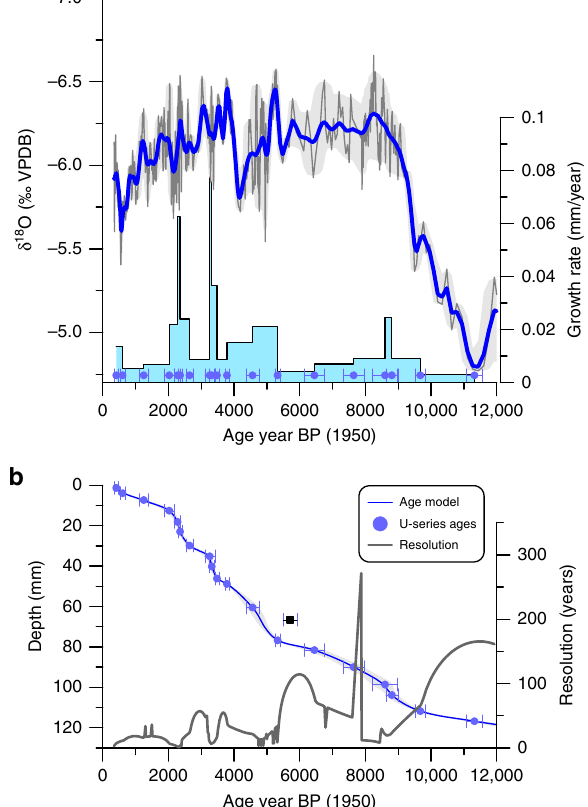
Fig. 1 Central American rainfall time series inferred by GU-RM1. a GU- RM1 δ 18 O time series (gray line and gray shading: measured values and age uncertainties; bold blue line: COPRA 61 output time series). b Age-depth model for 230 Th dates with gray uncertainty envelope from the COPRA modeling. The date at 67 mm depth was omitted from the age model and is shown for reference as a black square. The gray line shows the δ 18 O sampling resolution (years between